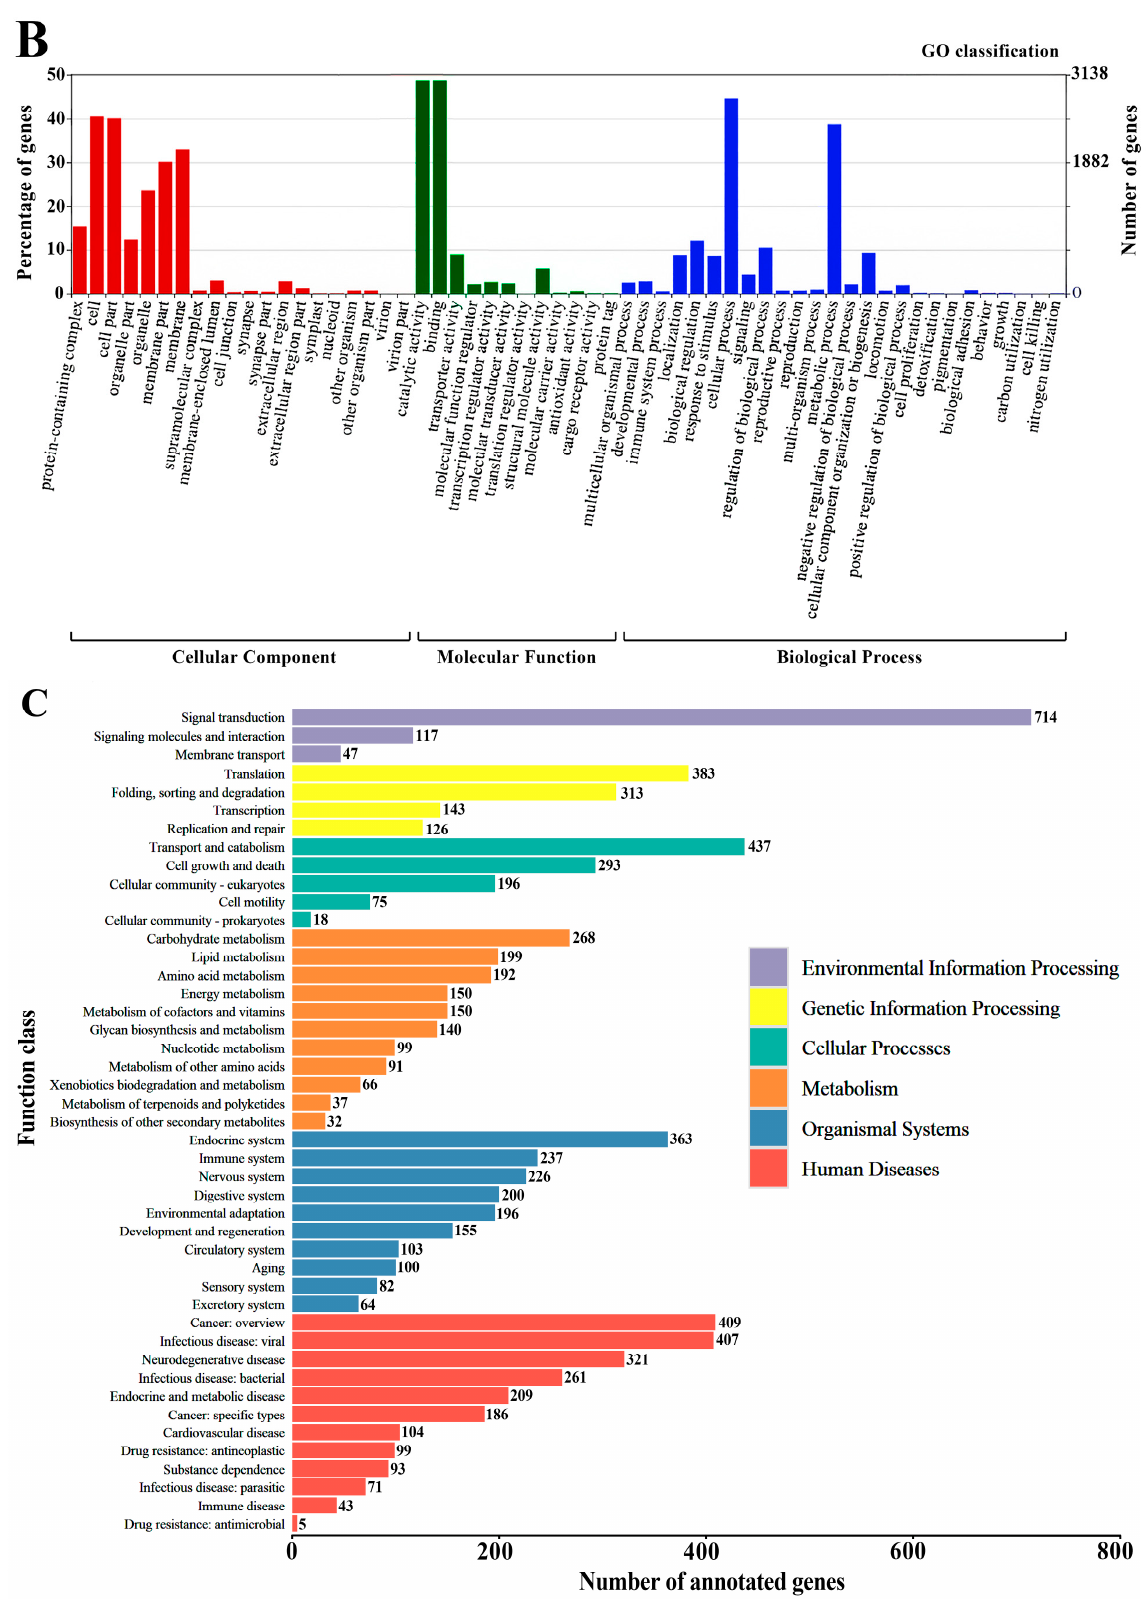
Figure 1. Functional annotations of O. loti unigenes. ( A ) The homology analysis of O. loti unigenes compared to other insect species. ( B ) Gene ontology (GO) classification of the O. loti unigenes. ( C ) The Kyoto encyclopedia of genes and genomes (KEGG) pathway enrichment analysis of O. loti unigenes.